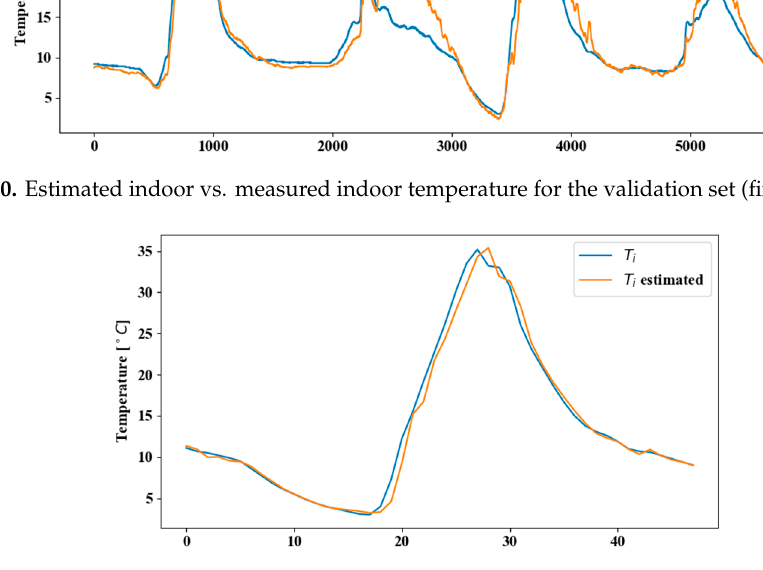
Figure 31. Estimated indoor vs. measured indoor temperature for the validation set (second experiment).